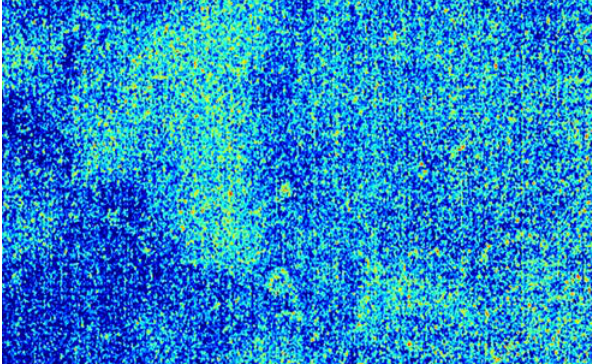
Figure 5. Derivative feature as reported in Fig. 4 computed after a preprocessing step of spatial and spectral smoothing.